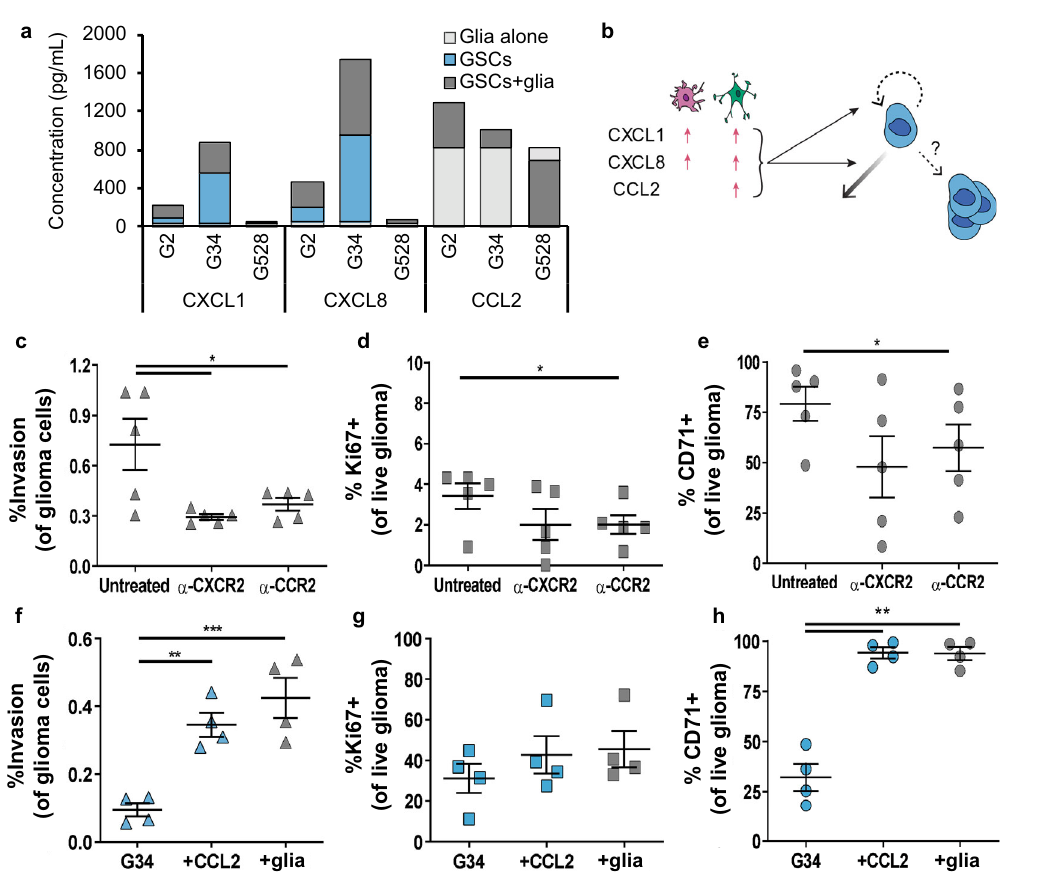
Fig. 4 Cytokine expression is altered in tri-culture, with CCL2 able to recreate many of the TME effects on glioma outcomes. a Cytokine expression based on a Luminex array for hydrogel samples of astrocytes and microglia alone (AM) and in combination with GSC lines G2, G34, or G528 in static conditions. The baselines for each glia-only and GSC monoculture condition are subtracted from the respective tri-culture condition to show synergistic as opposed to additive effects. Therefore, the total height of each bar (as opposed to relative height) shows the total cytokine expression for each condition. b Schematic showing what is known about the three cytokines pertaining to glial expression following activation and the known effects on glioma invasion, proliferation, and stemness (counterclockwise from left). c – e Effects of blocking the cytokine receptors CXCR2 (for CXCL1 and CXCL8) and CCR2 (for CCL2) in tri-culture under fl ow conditions on the outcomes of invasion ( c ), proliferation ( d ), and stemness ( e ). f – h Effects of adding CCL2 to GSC monoculture hydrogels vs. the full cellular TME in static conditions for invasion ( f ), proliferation ( g ), and stemness ( h ). Statistics performed by paired t -tests with * p < 0.05, ** p < 0.01, and *** p < these effects are all positively correlated, indicating these three “ malignancy ” metrics may increase similarly regardless of the experimental parameters.